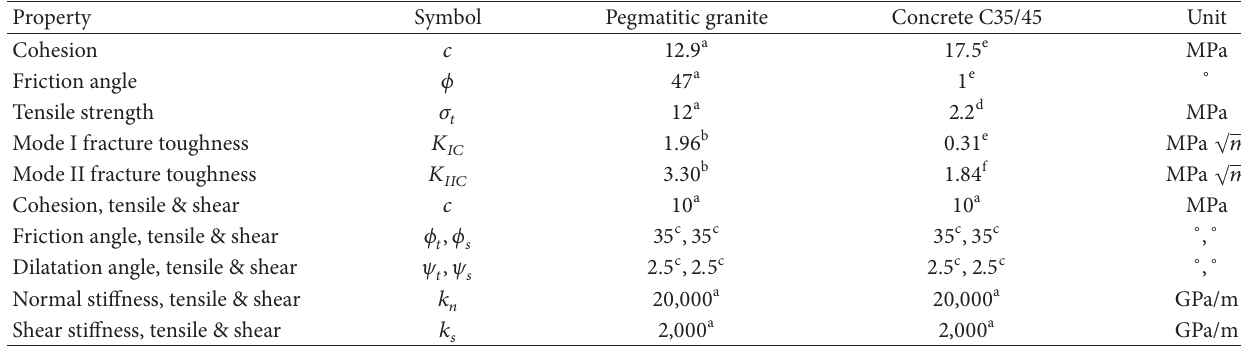
Table 6: Fracture mechanics modelling parameters.